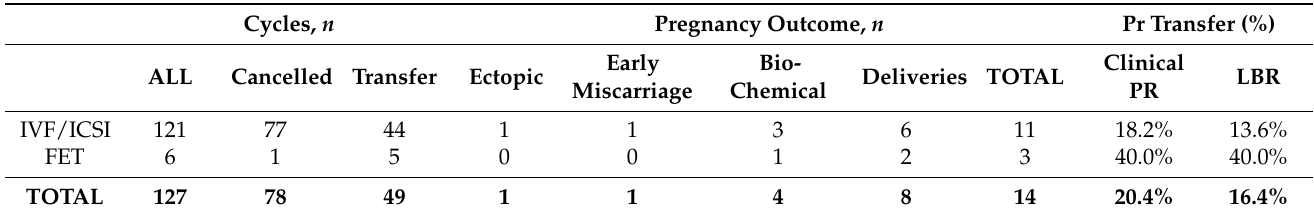
Table 4. ART treatments with and without pregnancy and pregnancy outcomes.